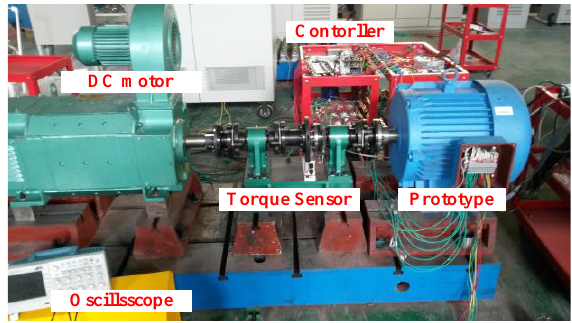
Figure 11. 36-slot/34-pole FSPM prototype and test platform.